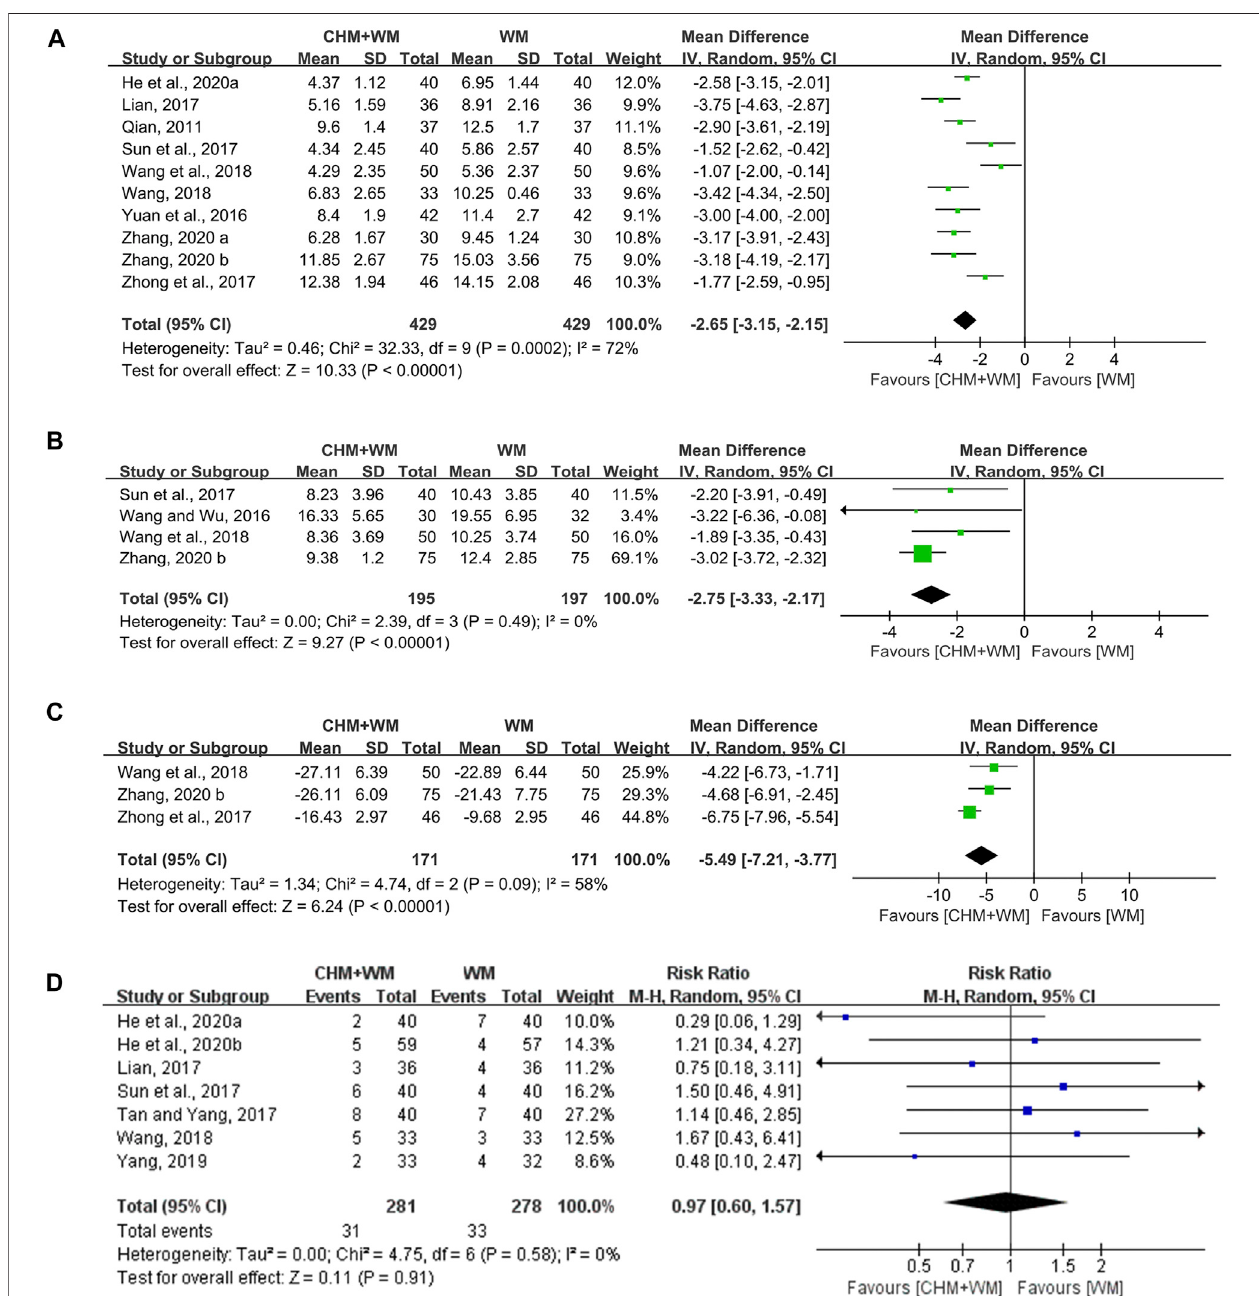
FIGURE 4 | Forest plots of secondary outcomes. (A) Lung rale disappearance time. (B) Lung X-ray in fi ltrates disappearance time. (C) TNF- α . (D) Adverse effects.